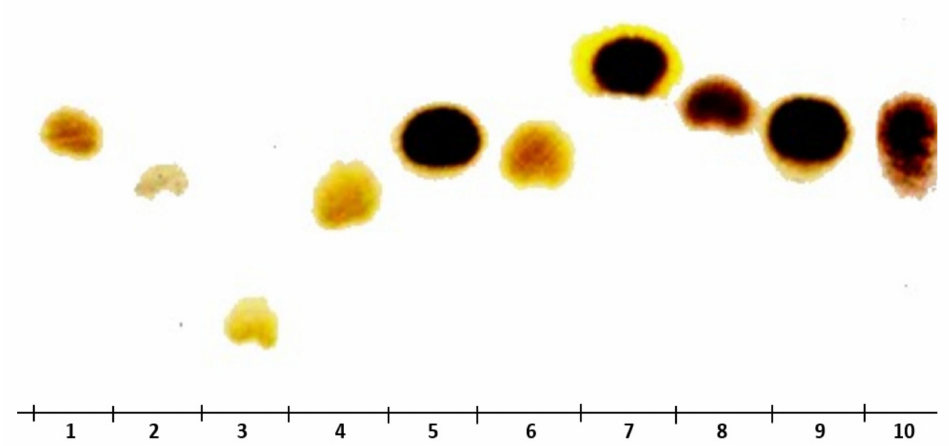
Figure 6. TLC analysis of KWSP, 1 arabinose, 2 glucose, 3 lactose, 4 galactose, 5 mannose, 6 fructose,